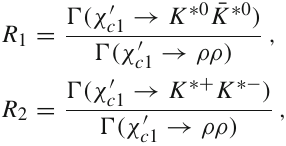
→ ρ + π − + c . c ) are about 2 . 67 × 10 − 5 c 2